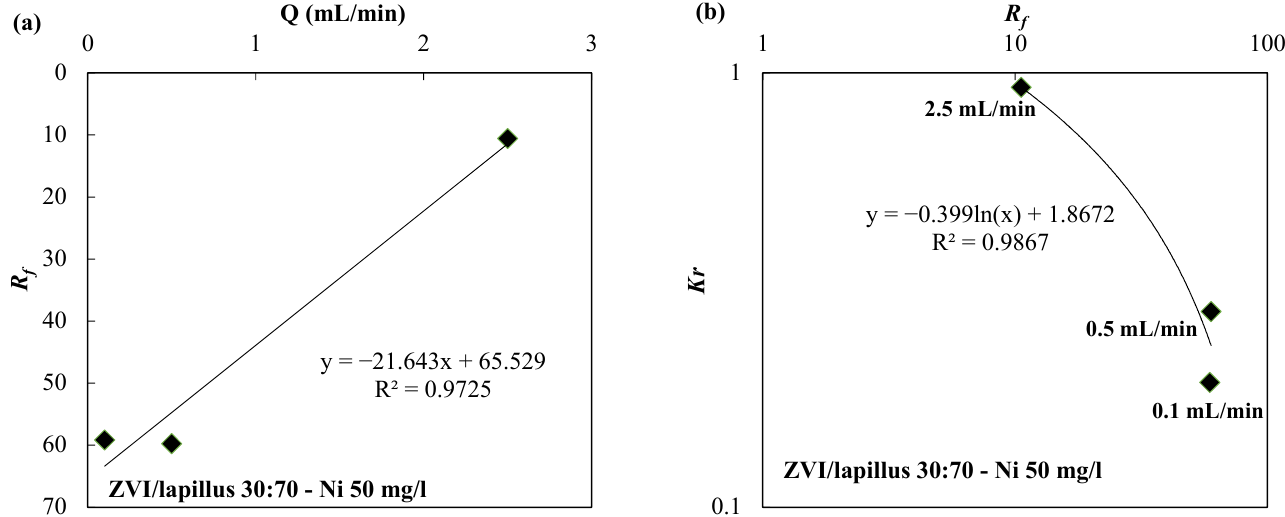
Figure 6. ( a ) R f vs. flow rate (Q) and ( b ) Kr vs. R f for the ZVI/lapillus granular mixture.